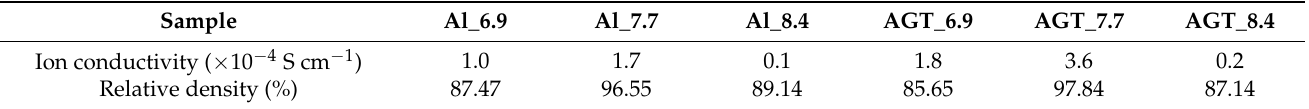
Figure 6. Nyquist plots of ( a , c ) the Al-doped LLZO pellets and ( b , d ) Al/Ga/Ta-doped LLZO pellets with different Li + concentrations (6.6, 7.7, and 8.4 mol). The fitting circuit is provided in the inset. Table 2. Summary of total (bulk + grain-boundary) ionic conductivity at 25 ◦ C and relative density of